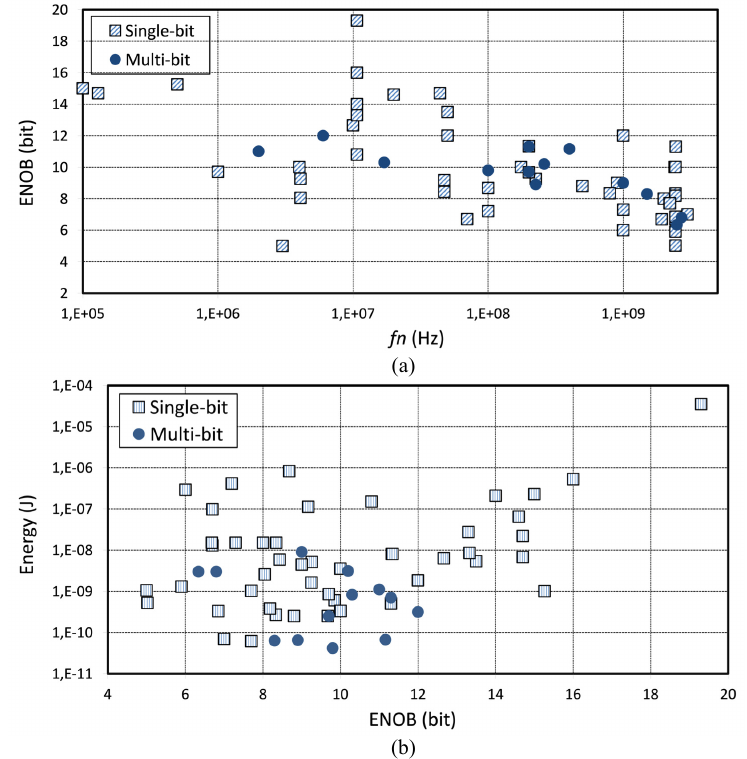
Figure 17. Second-order vs. High-order ( L > 2) BP- Σ∆ Ms: ( a ) ENOB vs. f n , ( b ) energy plot.